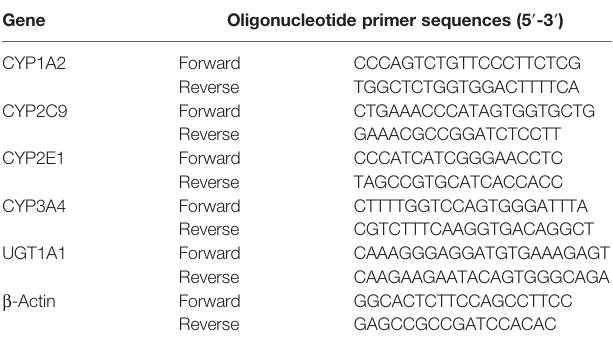
TABLE 4 | Primers for CYP1A2, CYP2C9, CYP2E1, CYP3A4, and